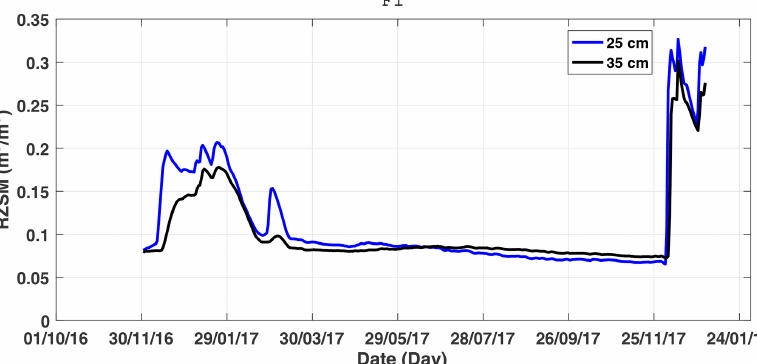
Figure A2. Time series of root zone soil moisture (RZSM) at 25 and 35cm of depth measured in F1 from 1 December 2016 to 31 December